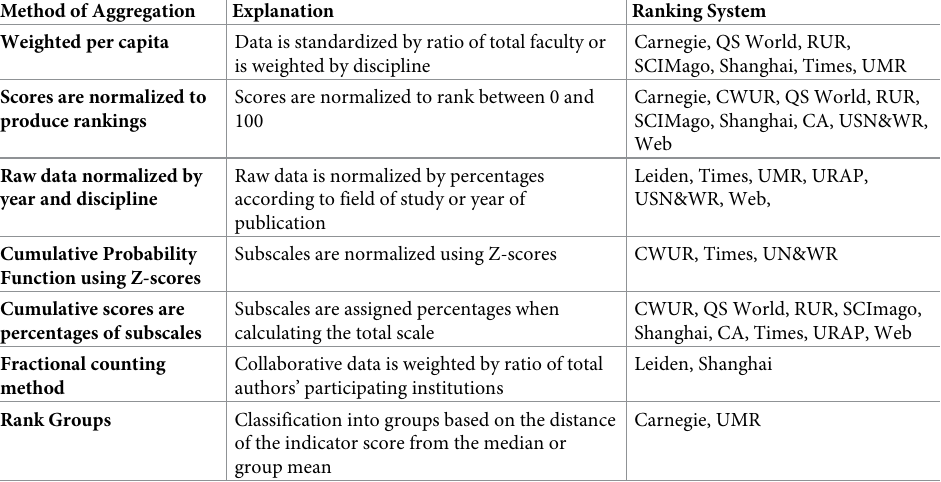
Table 6. Standardization and aggregation of indicators. Method of Aggregation